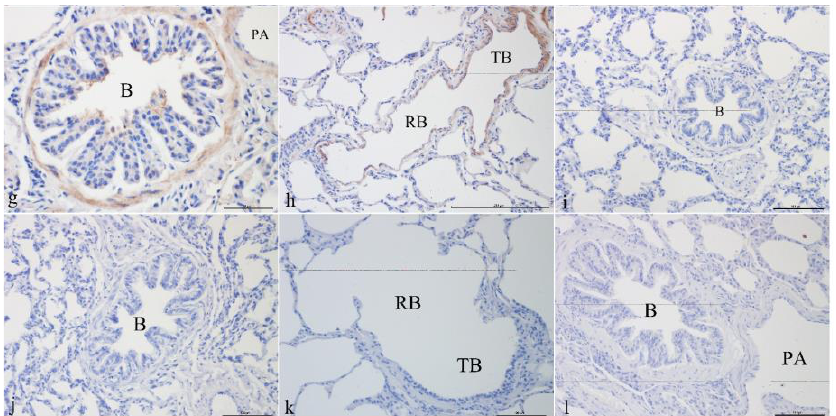
Figure 1. CFTR localization in yak lungs at different ages. ( a ) Bronchioles and pulmonary arteries of yak lungs in the newborn group (100 × ). ( b ) Bronchioles and pulmonary arteries of yak lungs in the newborn group (200 × ). ( c ) Terminal bronchioles of yak lungs in the juvenile group (200 × ). ( d ) Bronchioles and pulmonary arteries of yak lungs in the juvenile group (200 × ). ( e ) Bronchioles of yak lungs in the adult group (200 × ). ( f ) Bronchioles of yak lungs in the adult group (100 × ). ( g ) Bronchioles and pulmonary arteries of yak lungs in the elderly group (200 × ). ( h ) Terminal bronchioles and respiratory bronchioles of yak lungs in the elderly group (100 × ). ( i ) Blank control of bronchioles of yak lungs in the newborn group (200 × ). ( j ) Blank control of bronchioles of yak lungs in the juvenile group (200 × ). ( k ) Blank control of terminal bronchioles and respiratory bronchioles of yak lungs in the adult group (200 × ). ( l ) Blank control of bronchioles and pulmonary artery of yak lungs in the elderly group (200 × ). B—bronchiole; TB—terminal bronchiole; RB—respiratory bronchiole; PA—pulmonary artery.